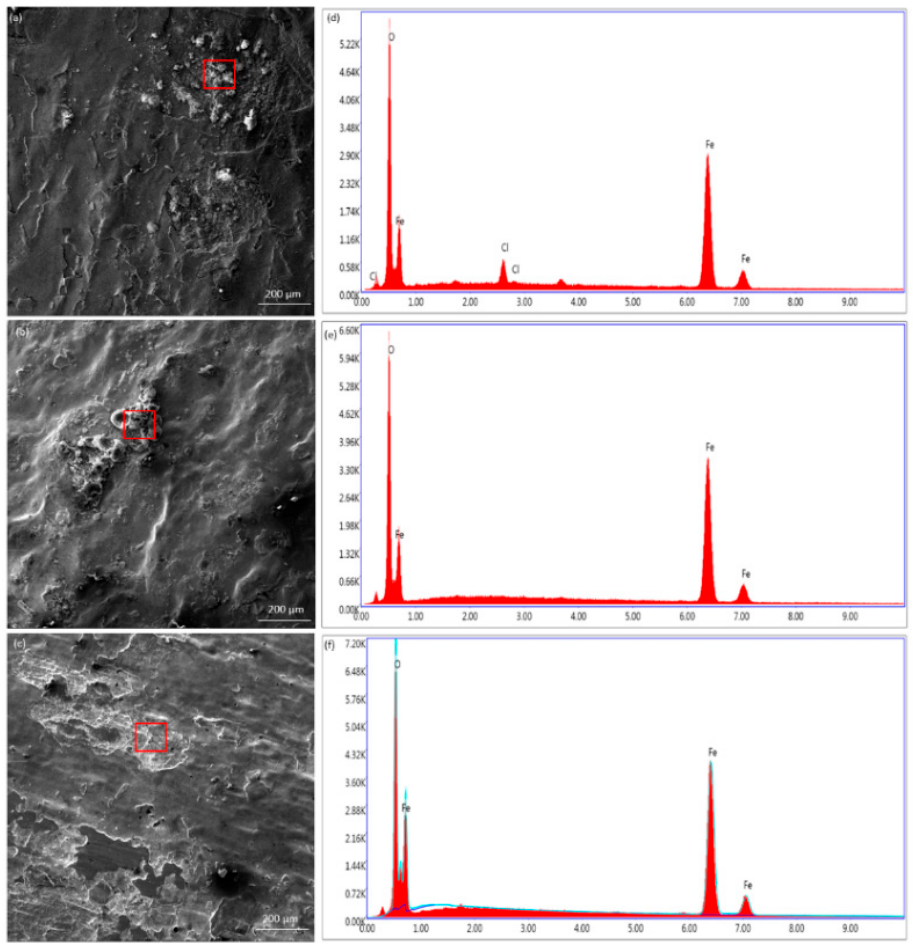
Figure 6. SEM and EDX images for steel rebar exposed to ( a , d ) 0.5:1, ( b , e ) 1:1, and ( c , f ) 1:0.5 molar ratios of NO 2 − :NO 3 − in SCPS contaminated with 0.6 M NaCl.